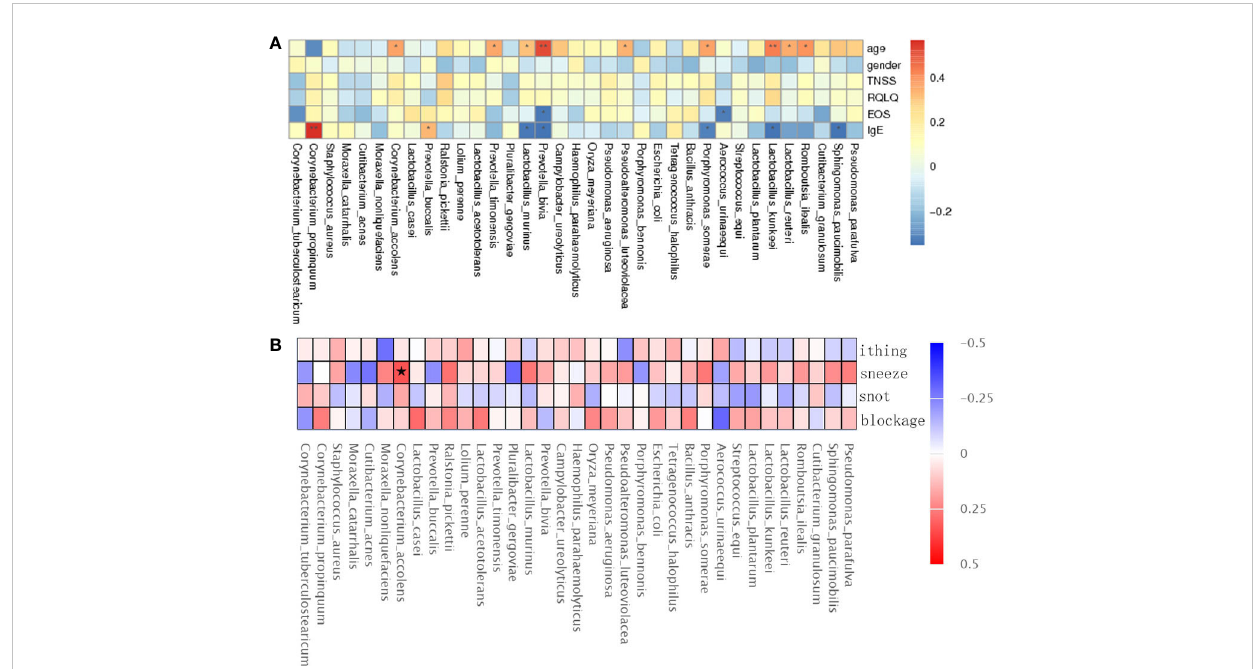
FIGURE 4 Spearman rank correlation analysis was used to correlate age, sex, TNSS, RQLQ scores, EOS, IgE (A) , and TNSS score details (B) with bacterial species. Correlation signi fi cance,* denotes p < 0.05 and **p <